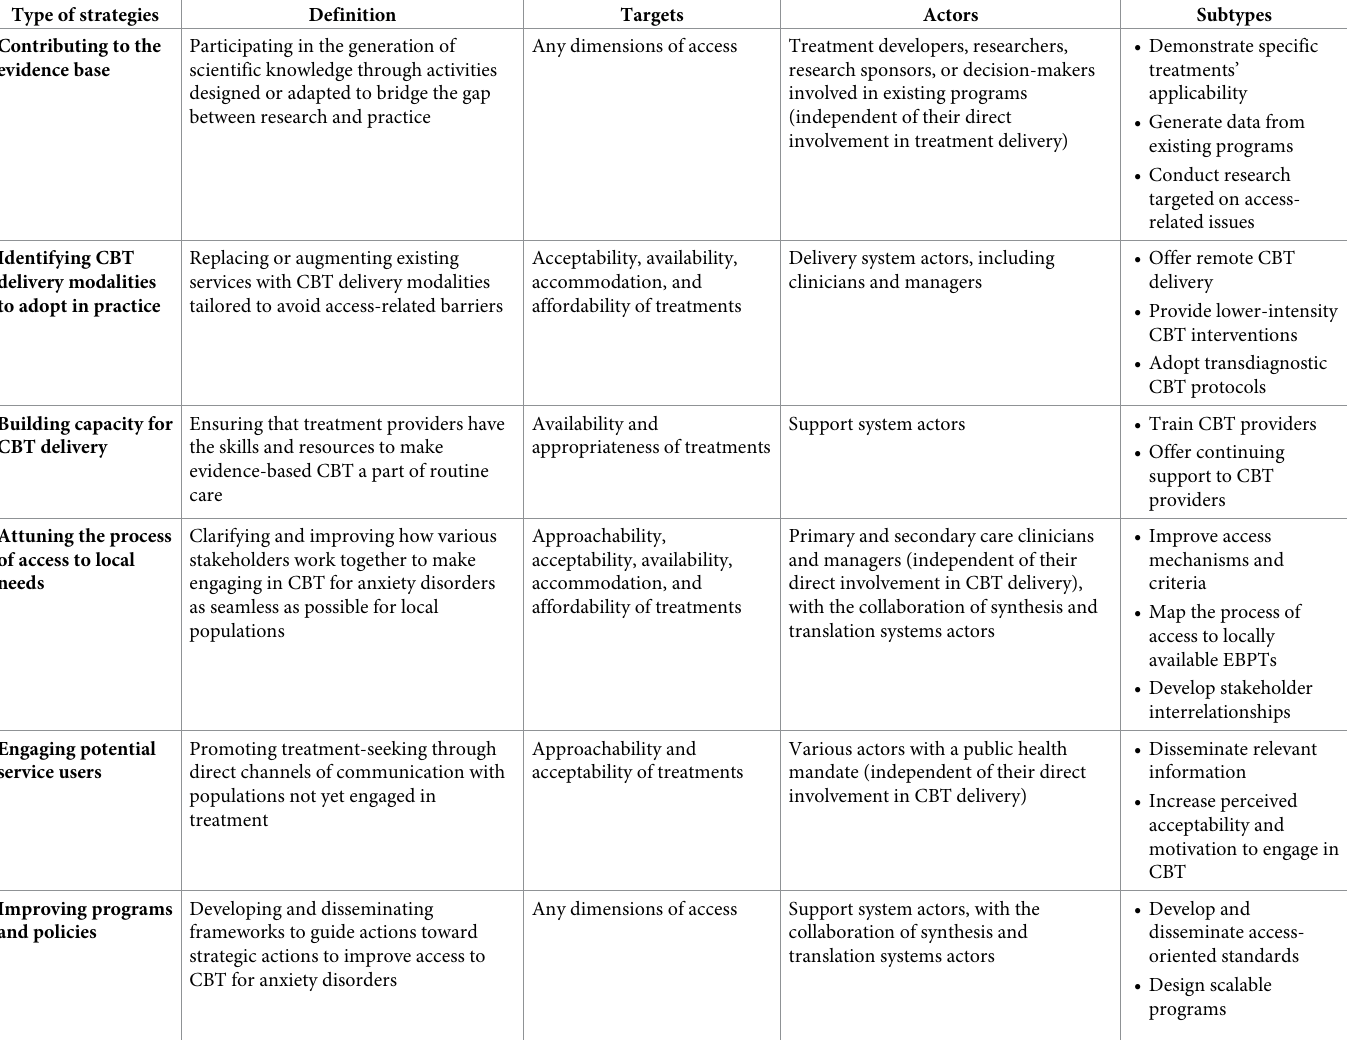
Table 1. Types of strategies to improve access to CBT for anxiety disorders and their